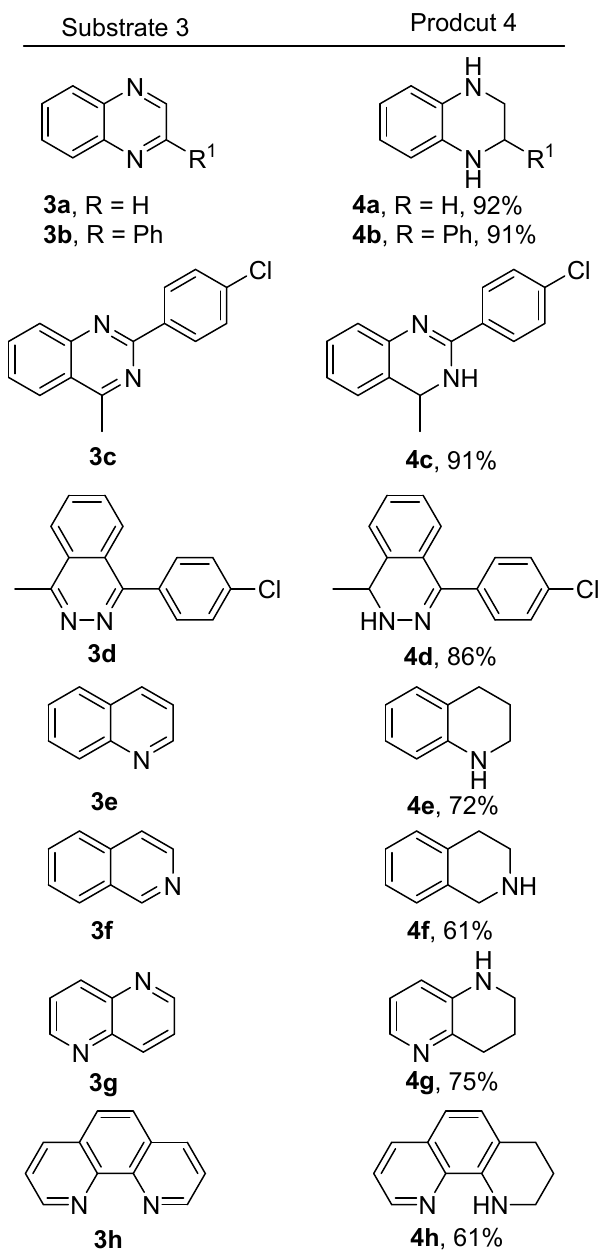
Figure 3. Substrate scope of the HMPA-catalyzed reduction of N -heteroarenes.